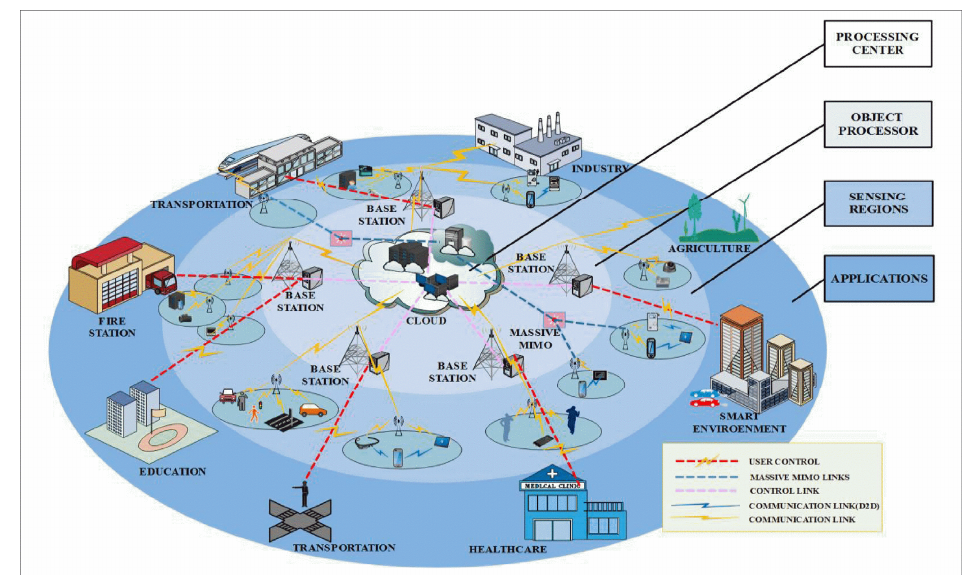
Figure 1. Connection architecture between 5G and Internet of Things (IoT). Reprinted with permission from Ref [5].